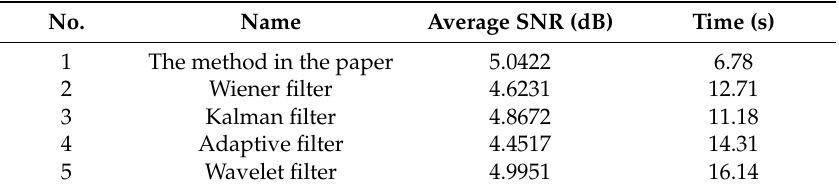
Table 2. Comparison of filtering effects among various methods.